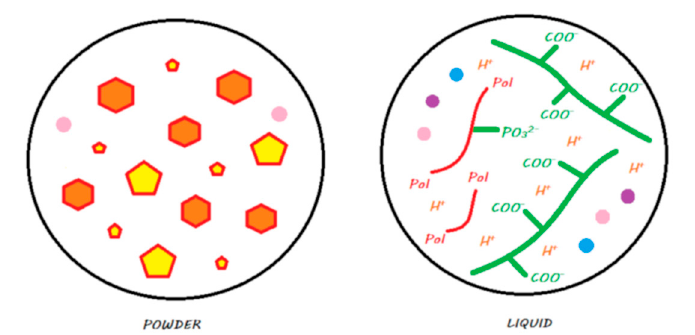
Figure 15. Diagram of Activa BioActive Restorative in its storage medium. The powder contains silanated FAS fillers, some chemopolymerization components, and silanated unreactive fillers. The liquid contains water, polyacrylic acid, a blend of monomers including phosphate dimethacrylate monomers, camphorquinone as a photoinitiator, and some chemopolymerization components.